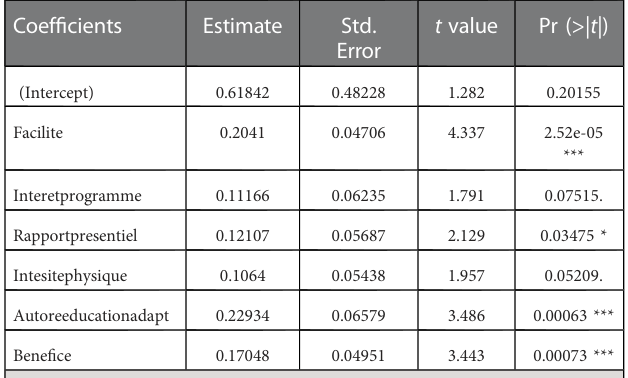
TABLE 3 Linear model of predictive values on satisfaction, pooled